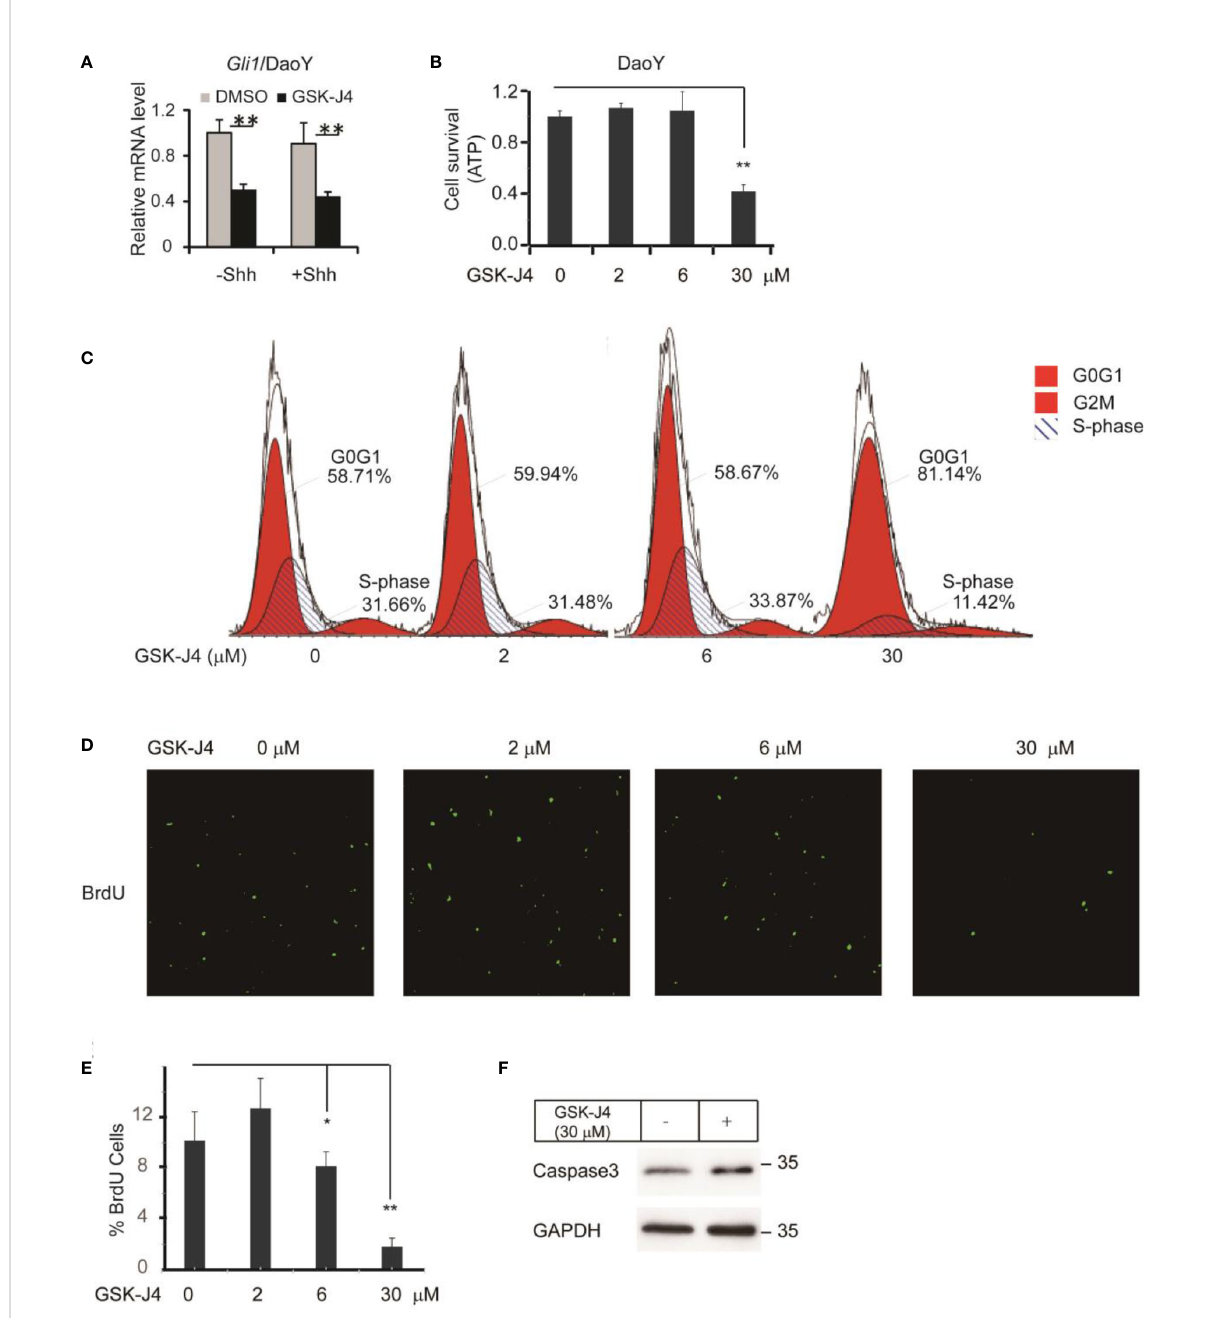
FIGURE 4 Growth of human DaoY medulloblastoma cells is inhibited and cells are arrested at G0/G1 by treatment of GSK-J4. (A) Shh target gene Gli1 expression is impaired by GSK-J4 in human medulloblastoma cell line DaoY. (B) Growth of DaoY Cells is inhibited by GSK-J4. (C) Growth of DaoY Cells is arrested at G0/G1 phase with decrease of S-phase by GSK-J4. (D, E) The proliferation of DaoY cells is reduced by treatment of GSK-J4. (F) Apoptosis of DaoY tumor cells is not dramatically induced by GSK-J4. Signi fi cance determined using Student ’ s t-test; * p <0.05, ** p